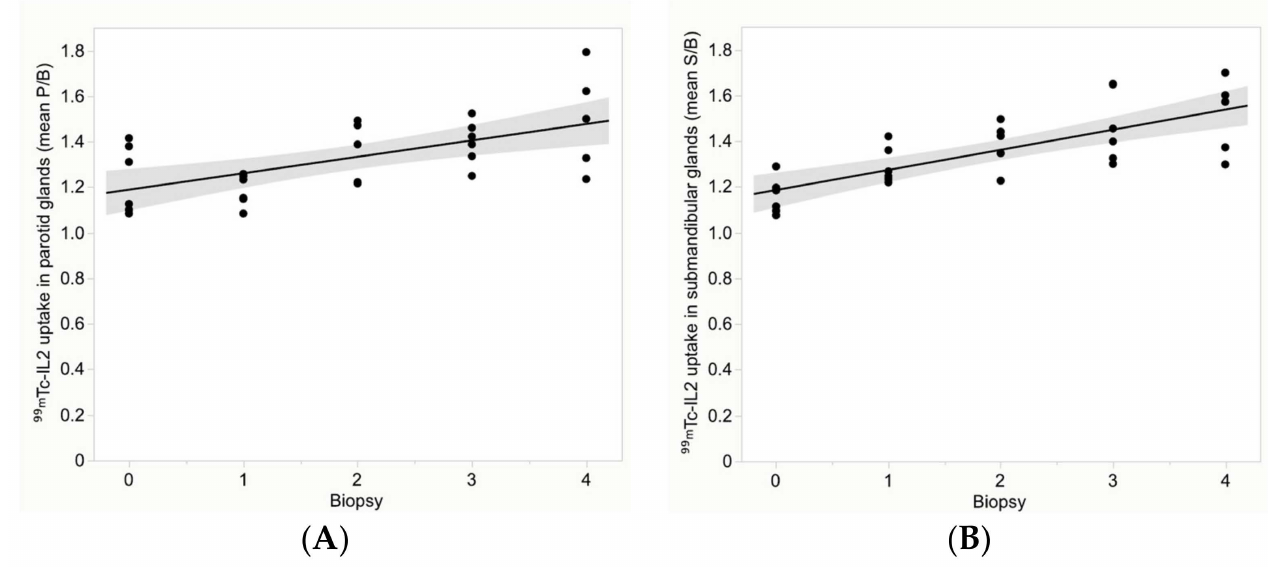
Figure 6. Distribution of the mean 99m Tc-IL2 uptake (P/B) in the parotid glands ( A ) and (S/B) in the submandibular glands ( B ) over the biopsy score. A significant correlation can be observed in all glands (correlation coefficient is 0.46 ( p = 0.001) for the parotids and 0.60 ( p < 0.0001) for the submandibular